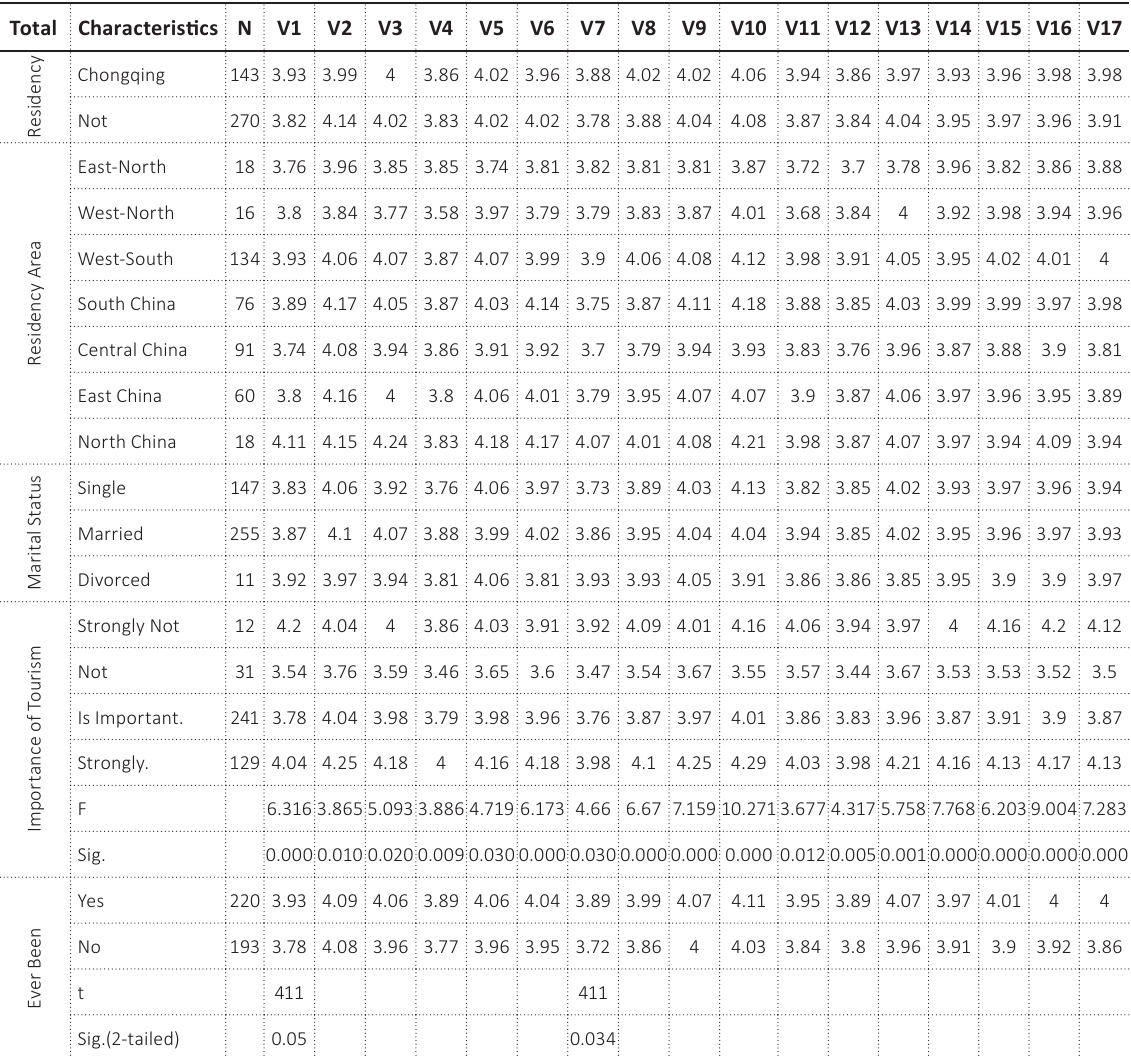
Table 8. ANOVA and T-test results – 2 Total Characteristics N